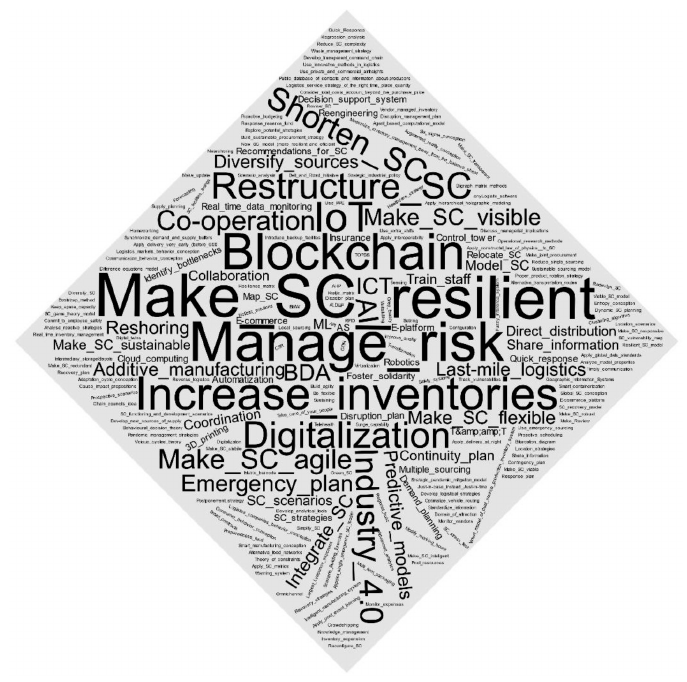
Figure 3. The map of keywords for the nineth criterion “theoretical concepts, methods, and tools proposed to manage SC during